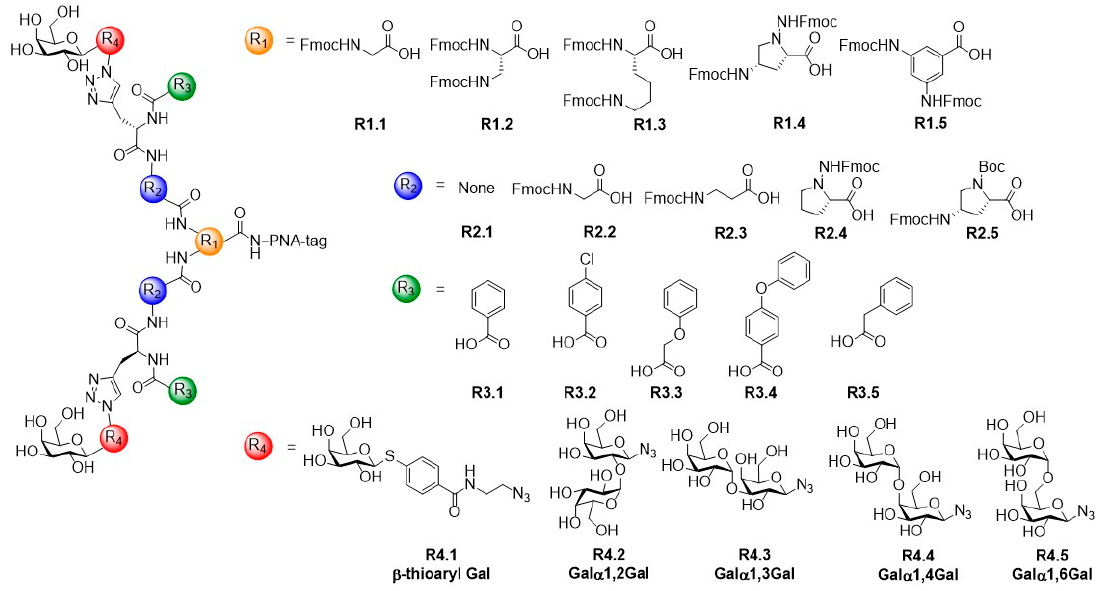
Figure 4. Design of a library consisting of bivalent galactosylated glycoconjugates with varying structural parameters to bridge the neighboring binding sites of LecA..